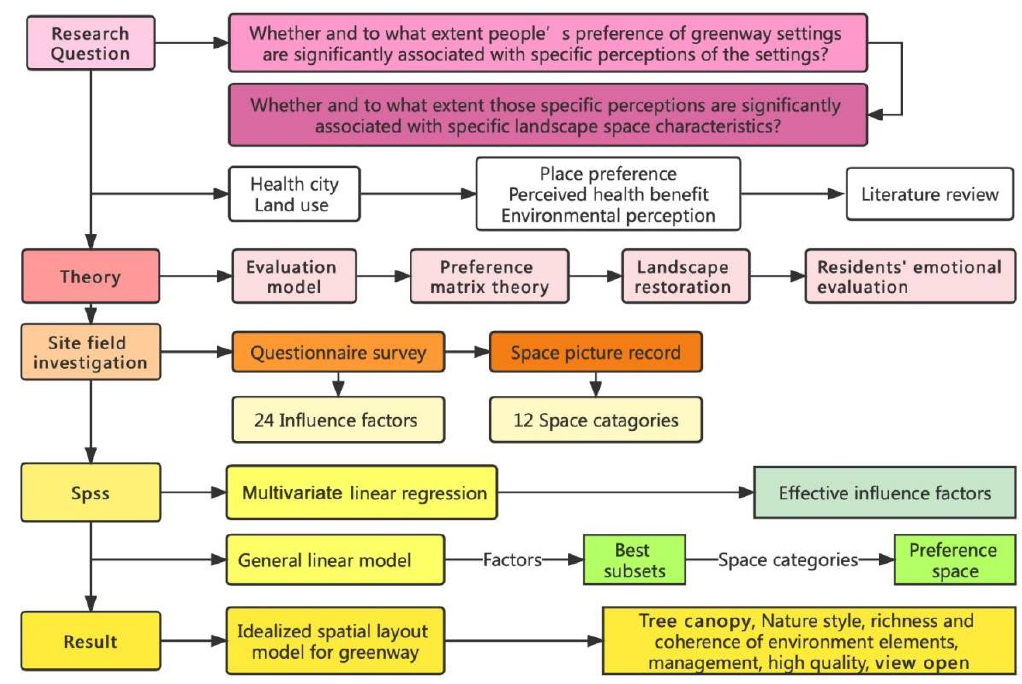
Figure 1. The research